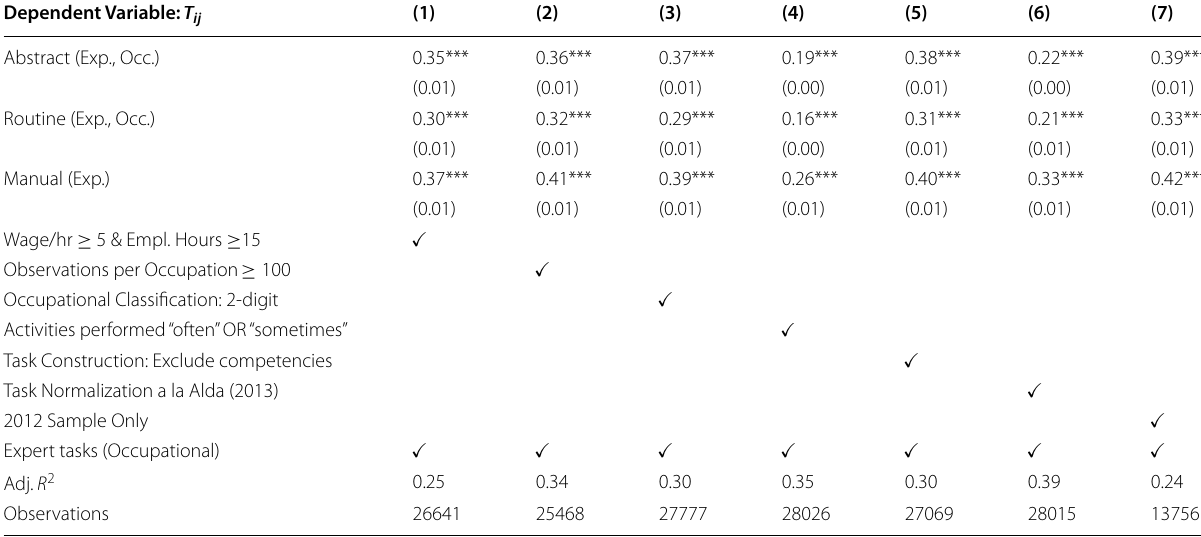
Robust standard errors in